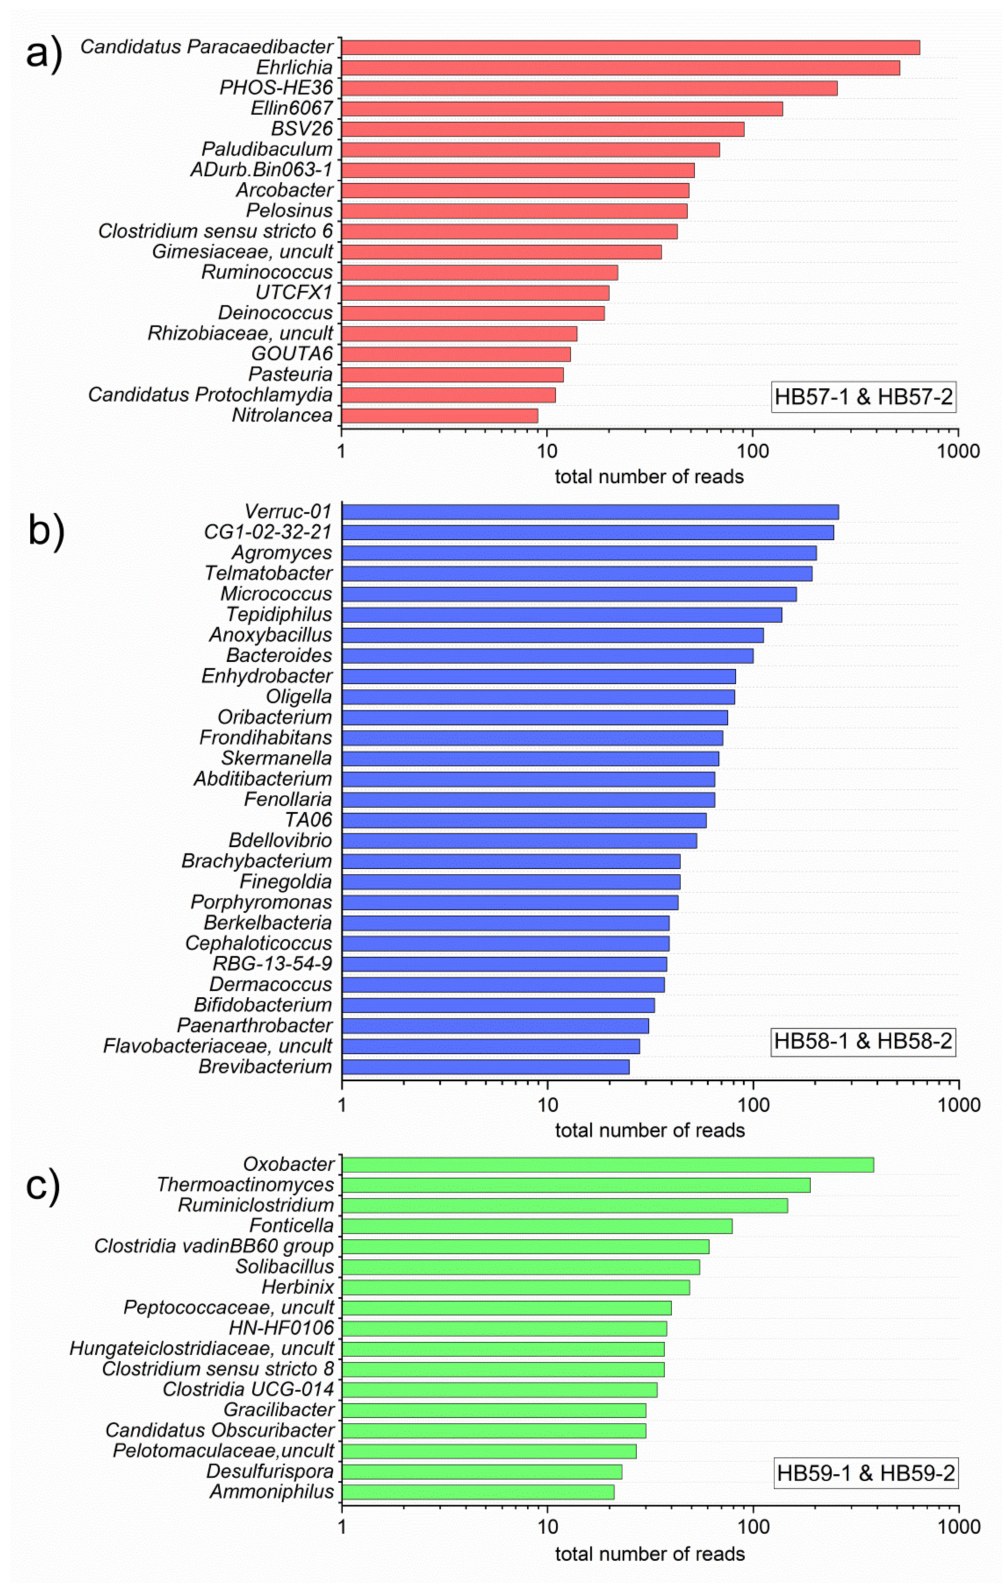
Figure 9. Exclusively observed OTUs (number of reads) for the three sampling sites: ( a ) coal seam (HB57-1 and HB57-2), ( b ) bright shaft filling sediment (HB58-1, HB58-2), and ( c ) topsoil sediment (HB59-1, HB59-2). The bars represent the sum of both samples of each sample